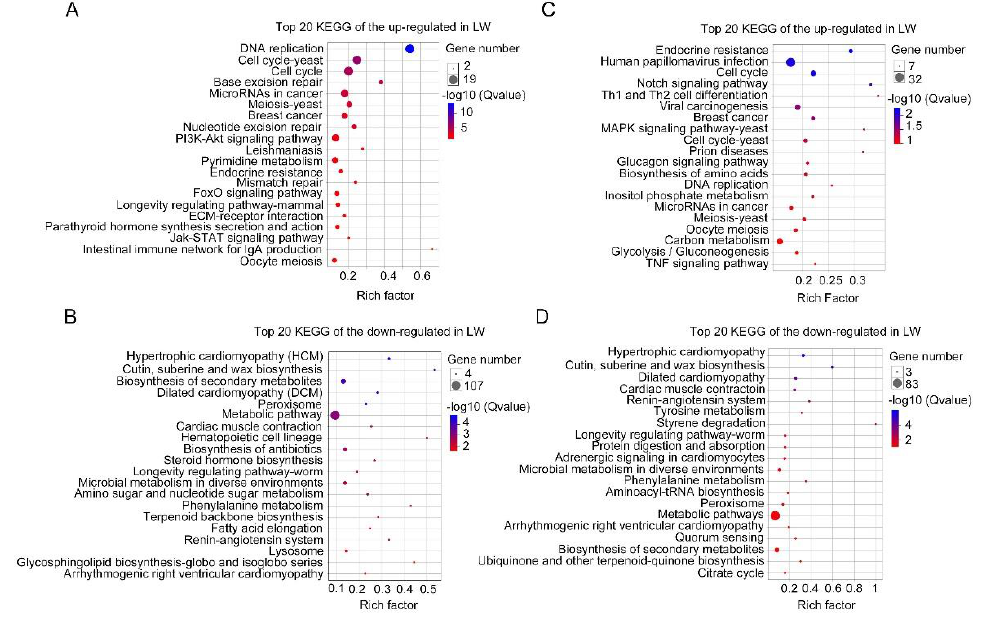
Figure 10. Top 20 enriched KEGG pathways of DEGs in 48 hAE-5th-instar nymphs with NlFoxO and Gfp knockdown. ( A , B ) Top 20 enriched KEGG pathways of up-regulated and down-regulated genes in forewing buds, respectively. ( C , D ) Top 20 enriched KEGG pathways of up-regulated and down-regulated genes in hindwing buds, respectively. The q -values in different colors denote significant enrichment. Different sizes of dots represent the number of genes enriched in each path- way.